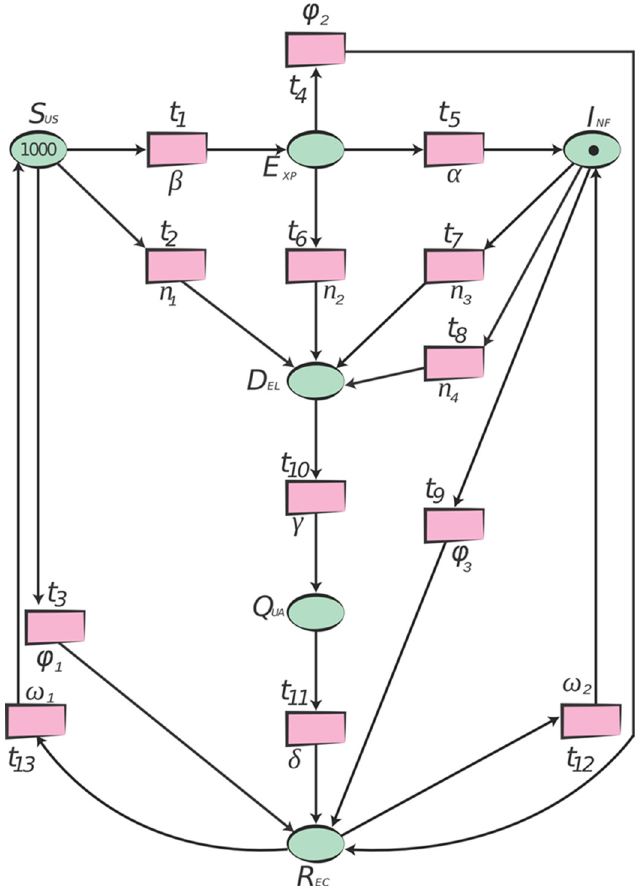
Fig 5. The SPN of the Proposed model. The SPN of the proposed model consists of a set of places P = { S US , E XP , I NF , D EL , Q UA , R EC } and set of transitions T = { t 1 , t 2 , t 3 , t 4 , t 5 , t 6 , t 7 , t 8 , t 9 , t 10 , t 11 , t 12 , t 13 } and initial marking M 0 = (1000, 0, 1, 0, 0,